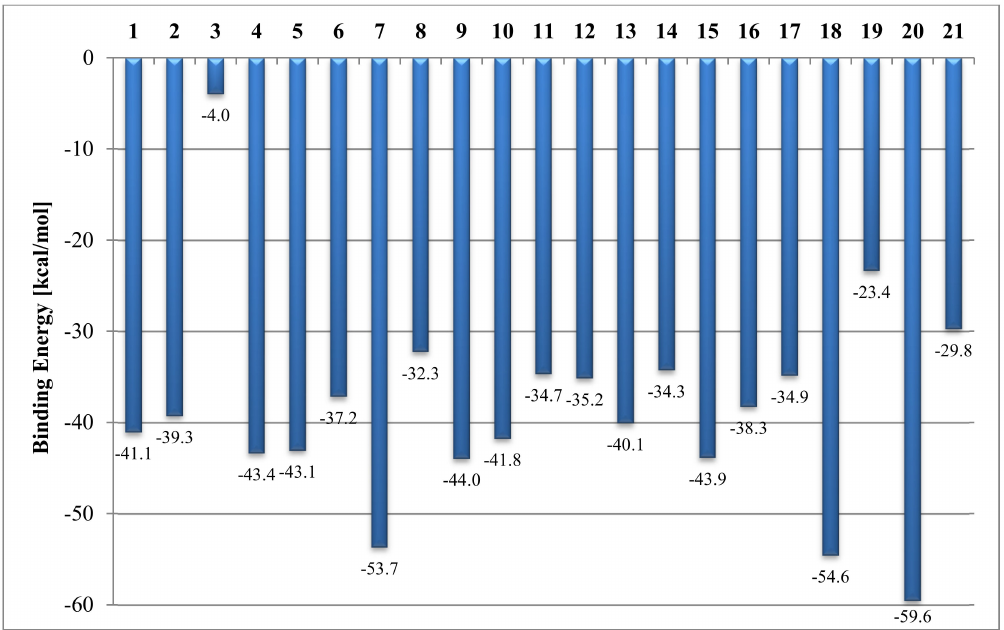
Figure 4. Comparison of binding energies of the tested compounds complexed with tubulin β I. Binding energies have been estimated using the MM / GBSA